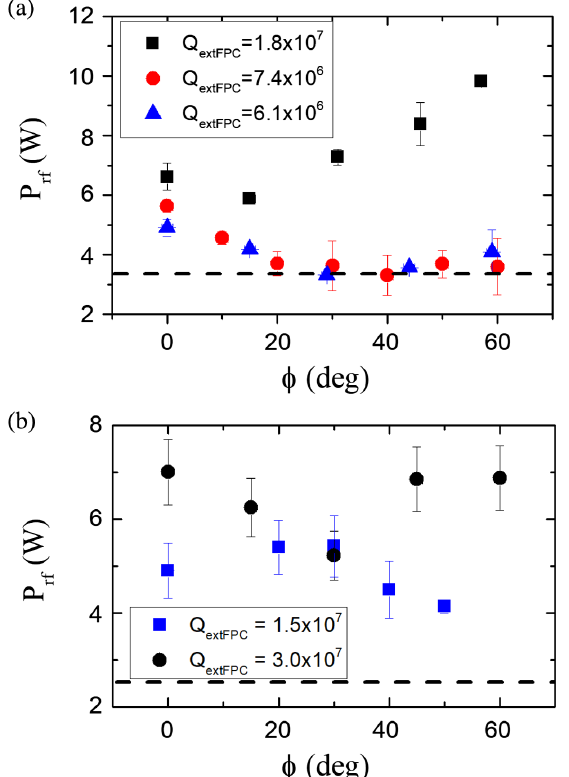
FIG. 15. The rf heat load at 2.07 K and 7 MV = m as a function of the detuning angle for different stub tuner settings, resulting in different Q values for cavity 1L13-4 (a) and 1L13-8 (b). extFPC The dashed lines represent the rf heat load measured at the same E value in the VTA test of each of these cavities, tested as acc cavity